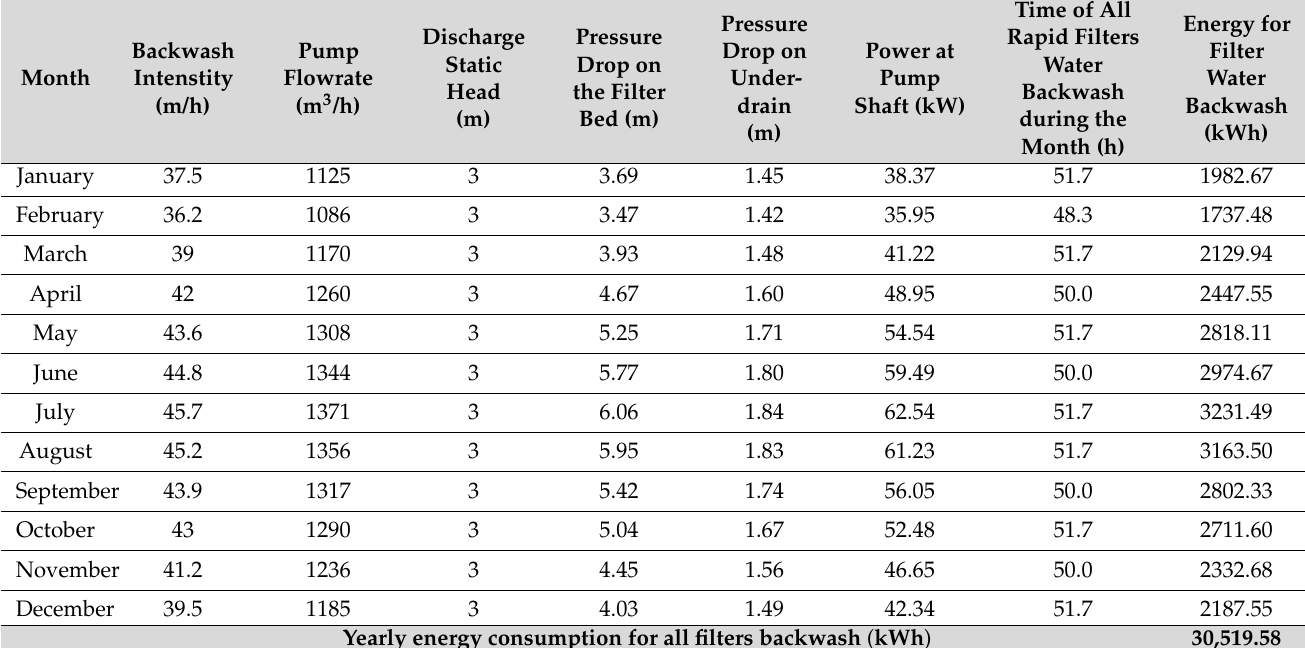
Table 7. Energy consumption for backwash of rapid filters with monthly adjustment of backwashing intensity.